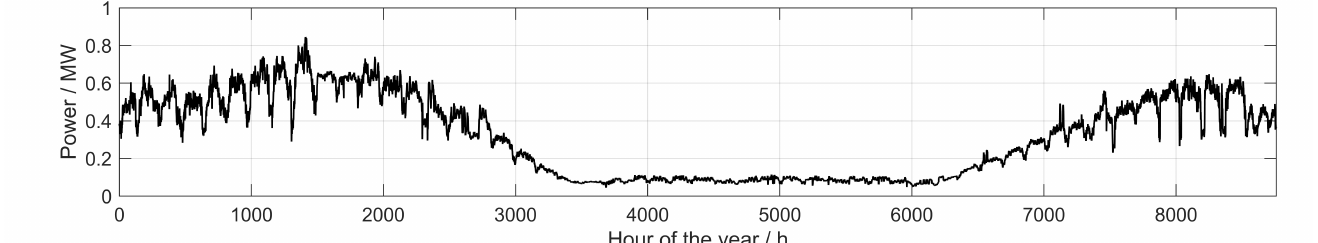
Figure 11. Consumed load from the dairy plant.